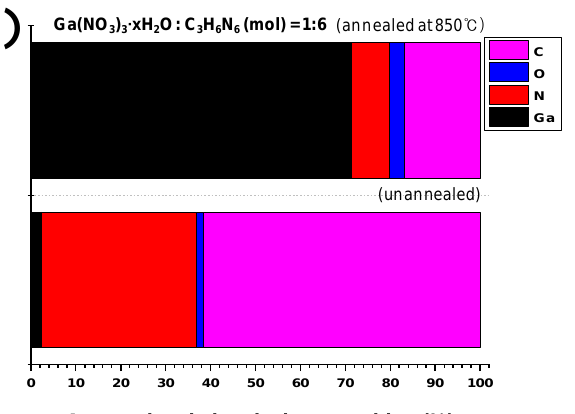
Figure 9. FE-TEM (field-emission scanning electron microscopy) and EDS (energy dispersive spectroscopy) results of product synthesized from a Ga(NO 3 ) 3 ∙32H 2 O pellet and C 3 H 6 N 6 powder injection with NH 3 gas by the thermal plasma process in Plasma 3; FE-TEM images of ( a ) before and ( b ) after annealing; ( c ) TEM-EDS results.